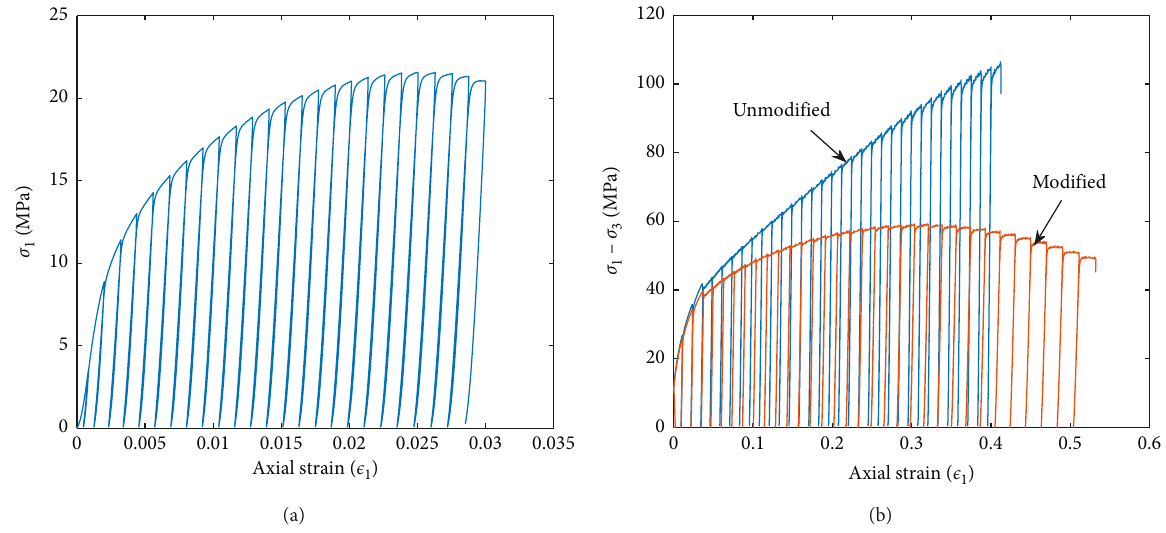
Figure 3: Stress-strain curves of rock salt in the compression test. (a) σ